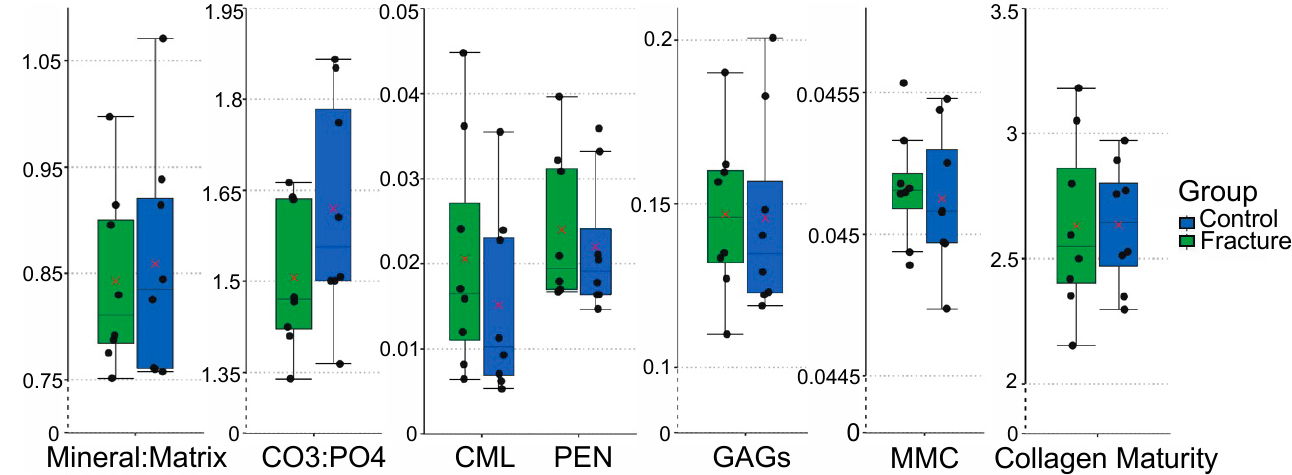
Figure 3. Box plots with jittered points of comparing the Raman spectroscopic outcomes of the fracture and control groups ( n = 8 samples/group) using the nine sub-region model. In each box, red cross marks indicate the estimated mean value, and horizontal lines indicate the median value of each parameter in each group. All Raman spectroscopic outcomes were similar across groups